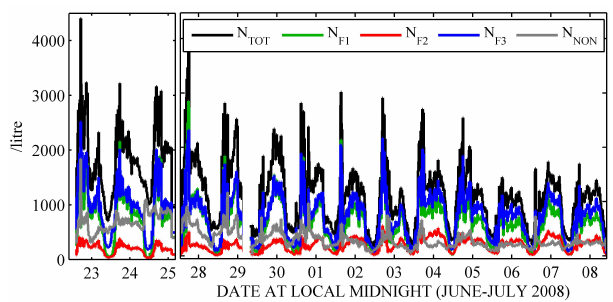
Fig. 6. Time series of WIBS3 Borneo number concentration, adapted from Gabey et al.